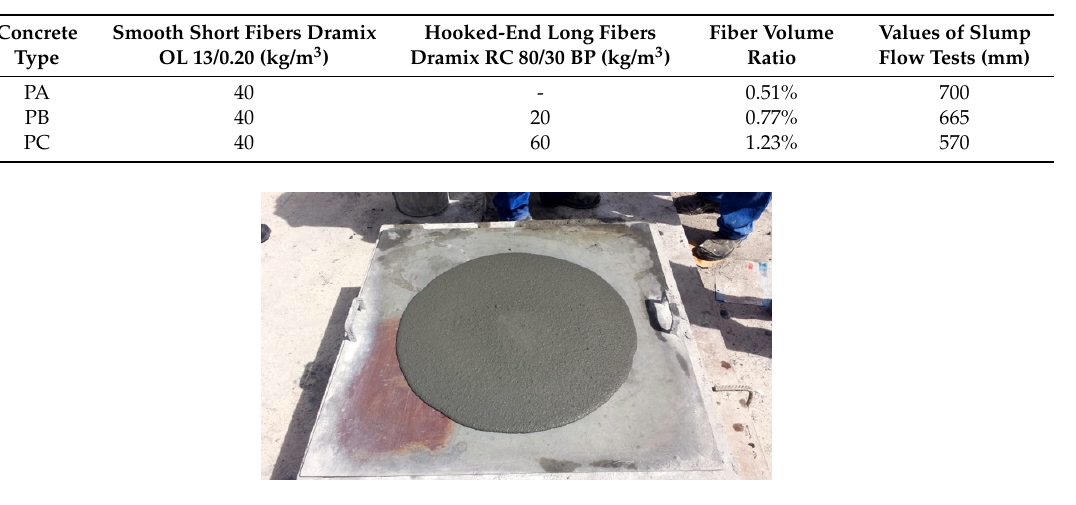
Figure 1. Slump flow test result (Concrete PC).